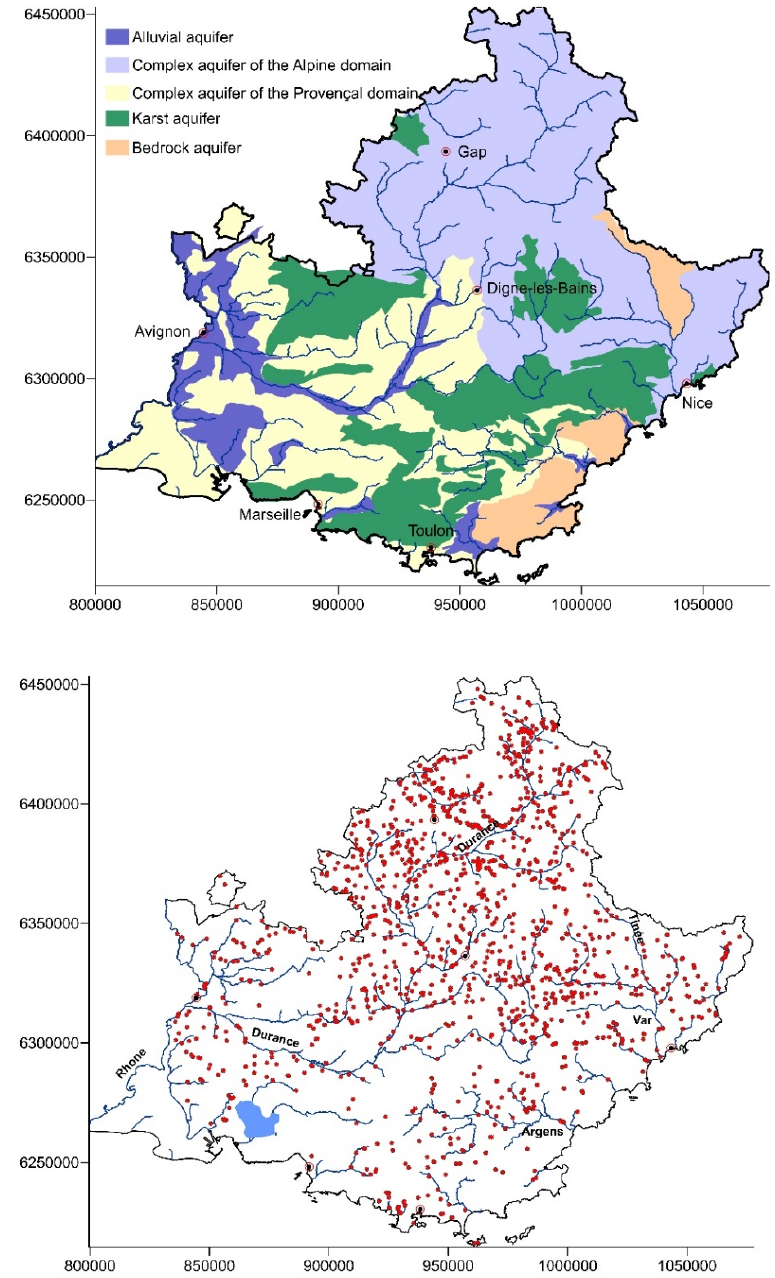
Figure 2. Main aquifer types ( a ) and location of the 1061 groundwater sampling points ( b ).